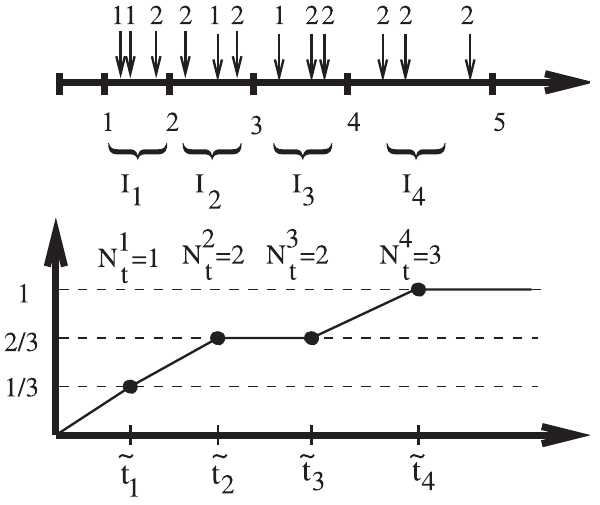
Figure 1. A simple illustration of the counting method. We use the method to approximate the probability distribution of stage 1 duration of a multistage disease. The top panel shows 12 patients’ visits. The horizontal axis is the time elapsed from stage 1 onset, and the numbers on top of vertical arrows indicate the stage assessment for each patient. The time-axis is split into 4 unequal intervals, I 1 , ... , I 4 , with J ~ 3 patient visits in each. The corresponding average visit times, ~ tt i , are calculated. In the i , and the numbers of transiting patients, N t bottom panel, the approximation ( ~ tt i , P 1 ( t i )) is plotted, where P 1 ( t i ) ~ N i = 3 t